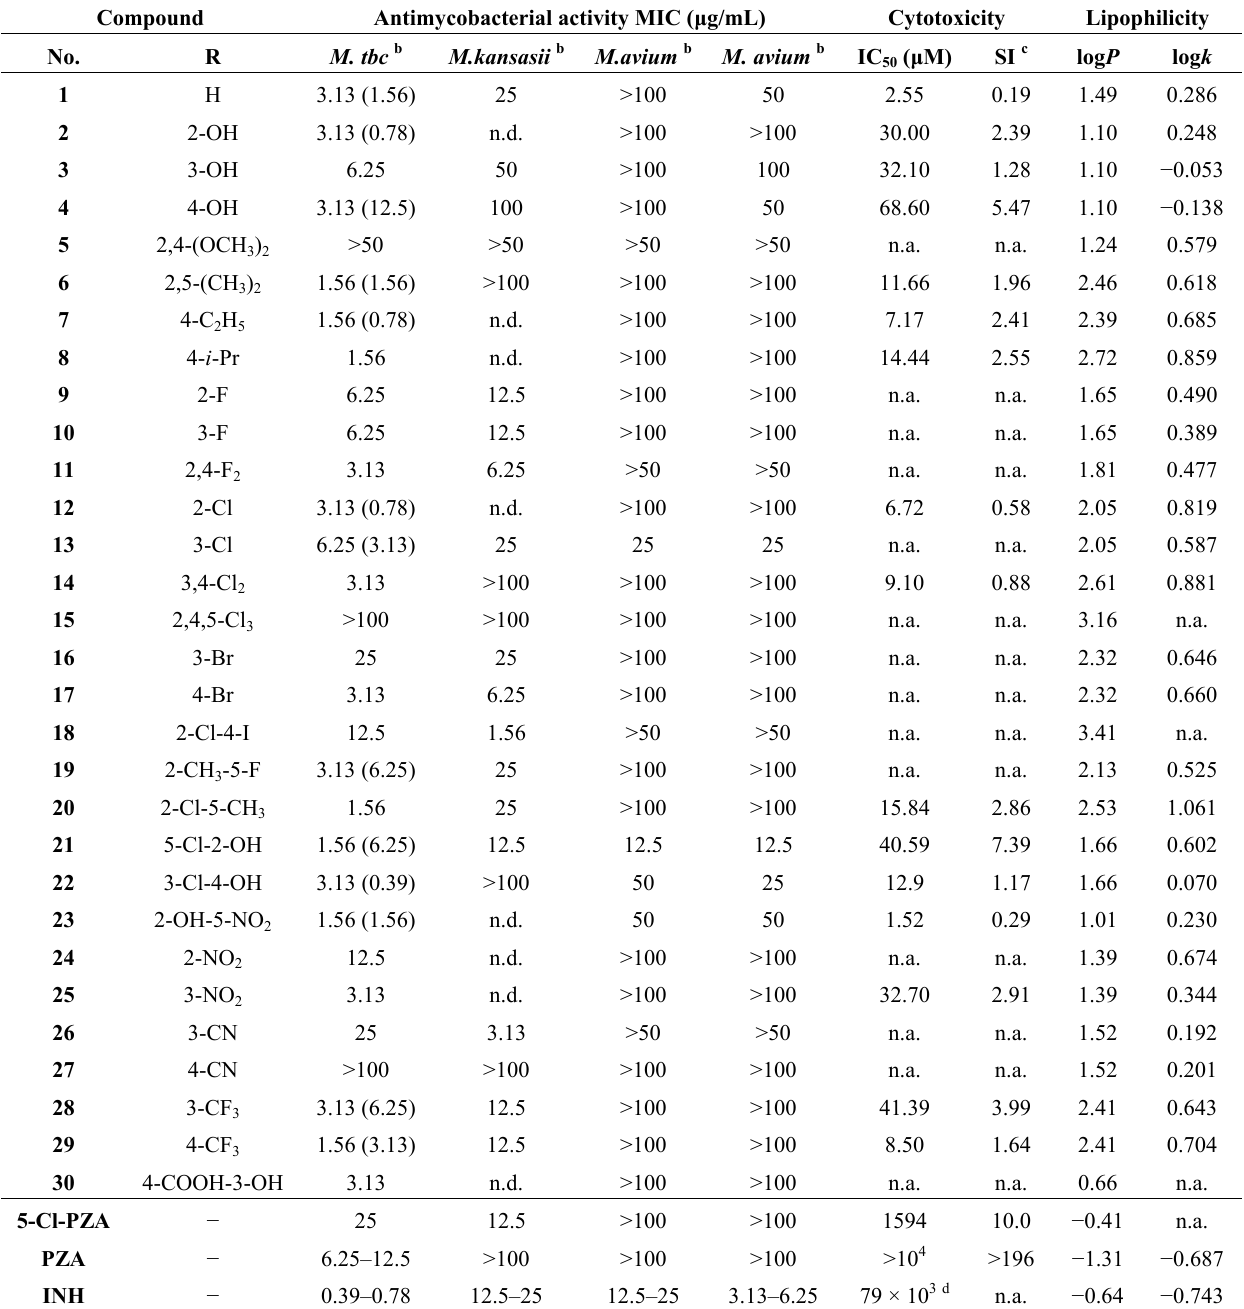
Table 1. Summary of prepared compounds, their antimycobacterial activity expressed as MIC ( μ g/mL), HepG2 cytotoxicity, and calculated and measured lipophilicity parameters a